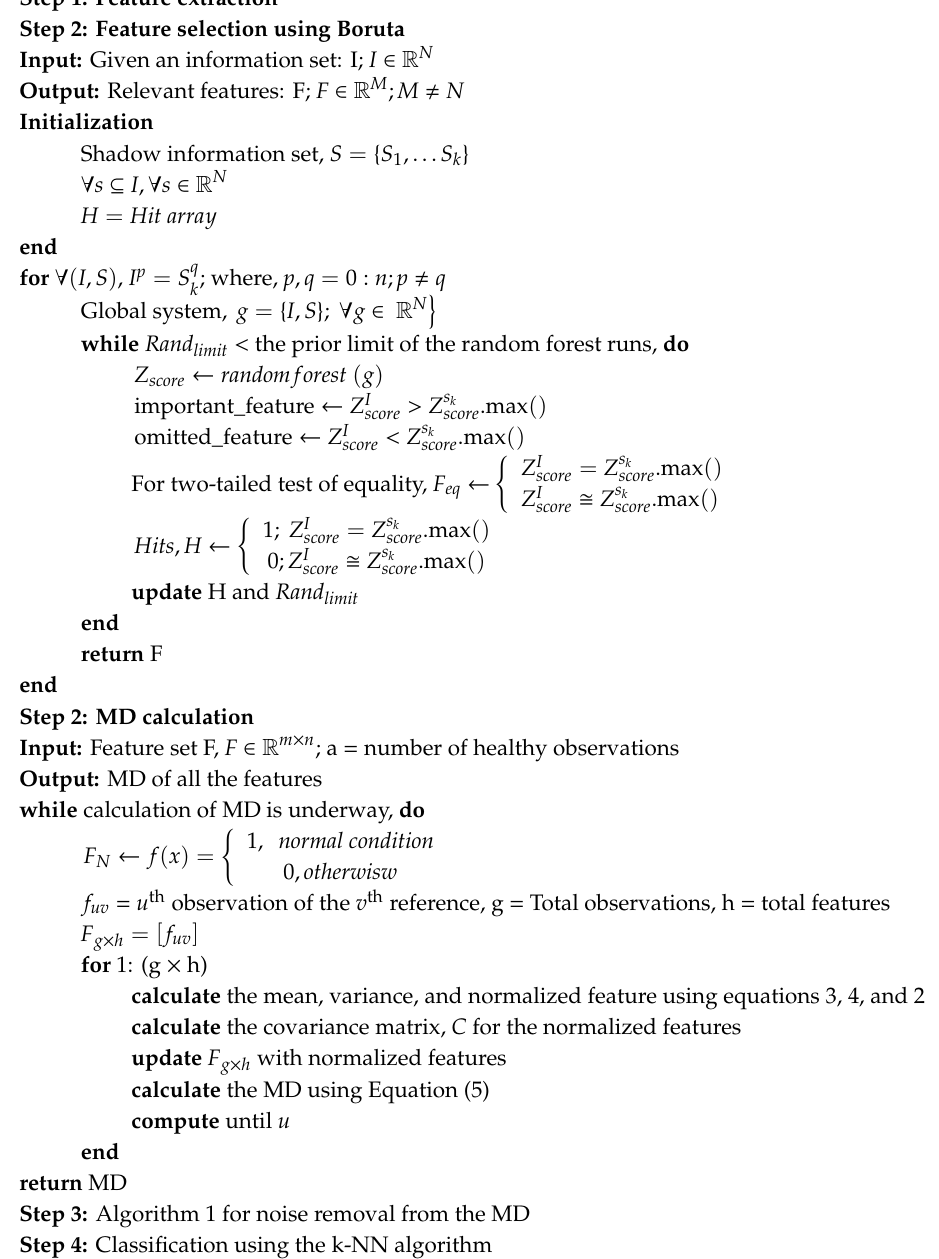
Algorithm 2 Algorithm of the proposed